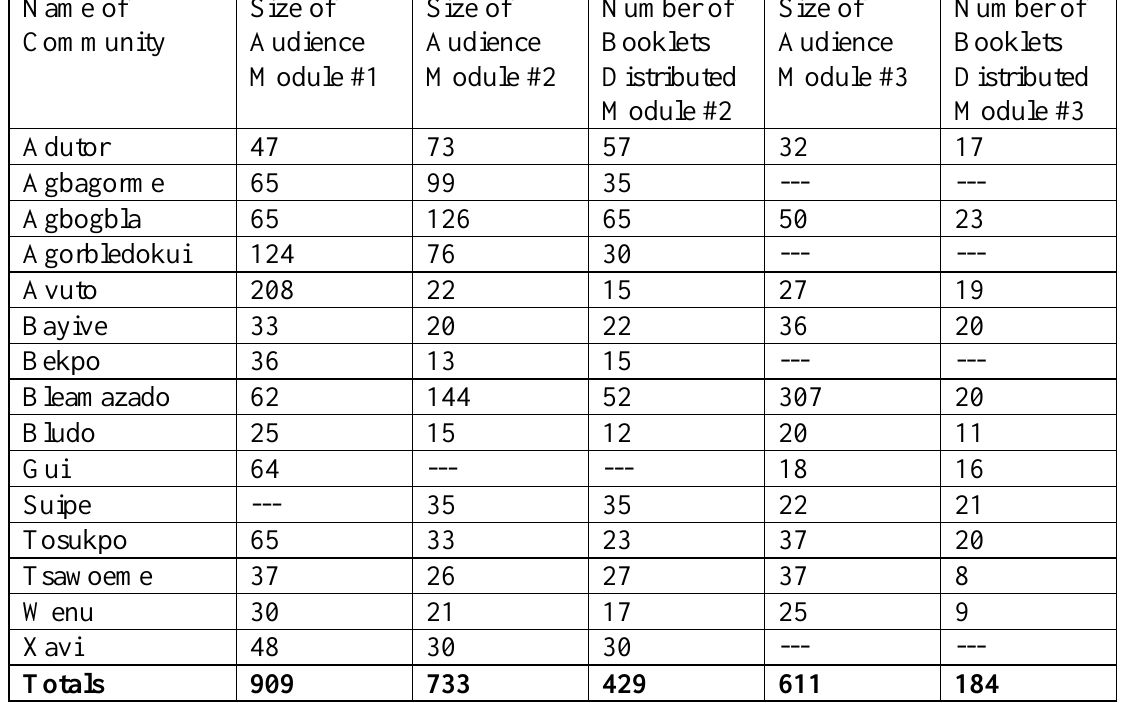
Table A1 Number of participants present and booklets distributed during EET workshops for Modules 1-3